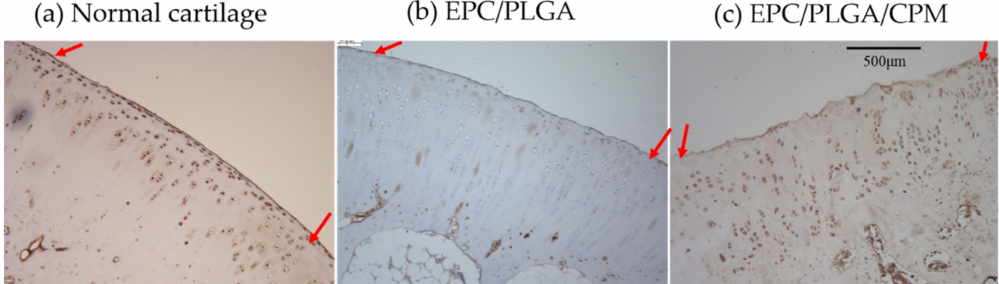
Figure 7. Representative images of superficial proteins in the defect sites detected by IHC staining. Lubricin immunostaining in dissected cartilage samples was visualized throughout the extracellular matrix of all groups. Normal cartilage ( a ): A very strong lubricin staining (intensity of staining (IS) = 4; extent score (ES): ++++) was observed; EPC/PLGA group ( b ): Weak lubricin immunoreactivity (IS = 1; ES: +); EPC/PLGA/CPM group ( c ): Robust lubricin staining (IS = 4; ES: ++++). A red arrow shows the border of the repaired tissue. Scale bar 500 µ